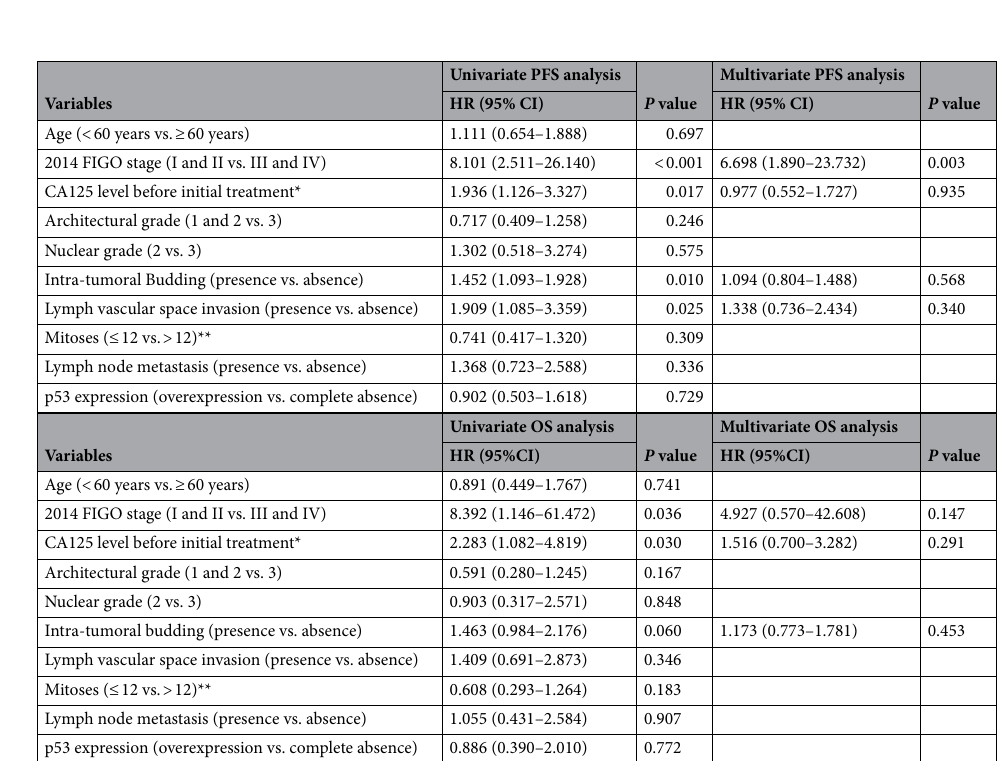
Table 2. Univariate and multivariate survival analyses for progression-free survival (PFS) and overall survival (OS) of the patients with high-grade serous ovarian carcinoma. HR hazard ratio, CI confidence interval. *Median, 680.0 U/ml (≤ 680.0U/ml vs. > 680.0 U/ml). **X 10 high power fields.